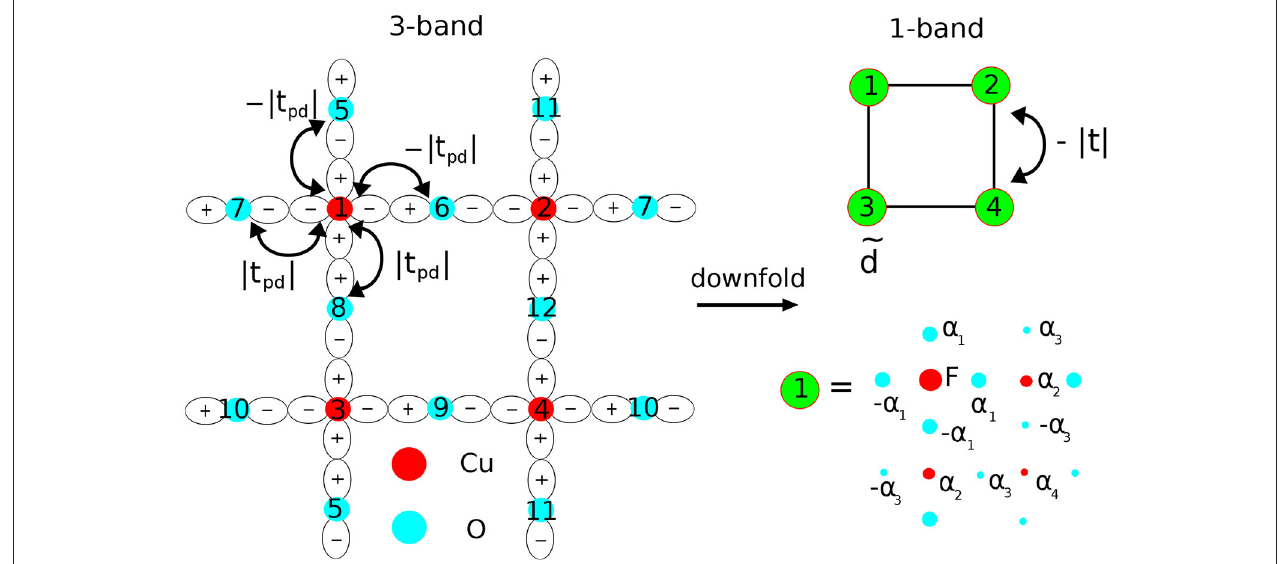
FIGURE 2 | Schematic for downfolding the three-band Hubbard model on the 2 2 cell to the one-band Hubbard model. The oxygen orbitals are eliminated to give × “dressed” d -like orbitals of the one-band model, with modified hopping and interaction parameters. The relationship between the ˜ d and the copper and oxygen orbitals is encoded by a linear transformation which is parameterized by α 1 , α 2 , α 3 , α 4 and F (see Appendix for more details). Here the diameter of the circles has been shown to be proportionate to the magnitude of F or α i .